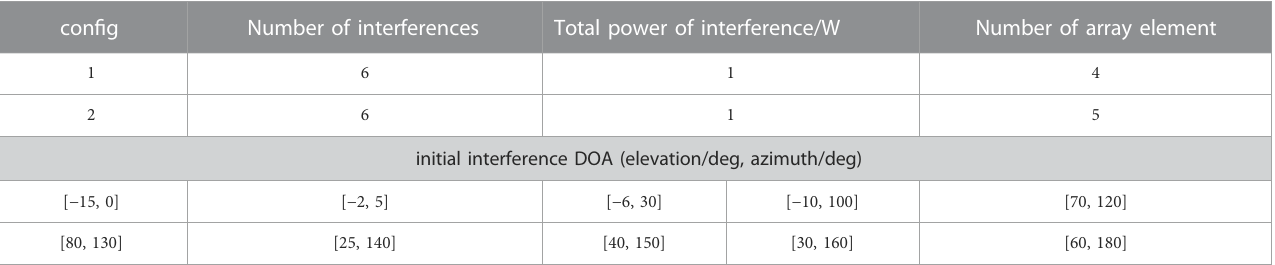
TABLE 3 Jamming con fi